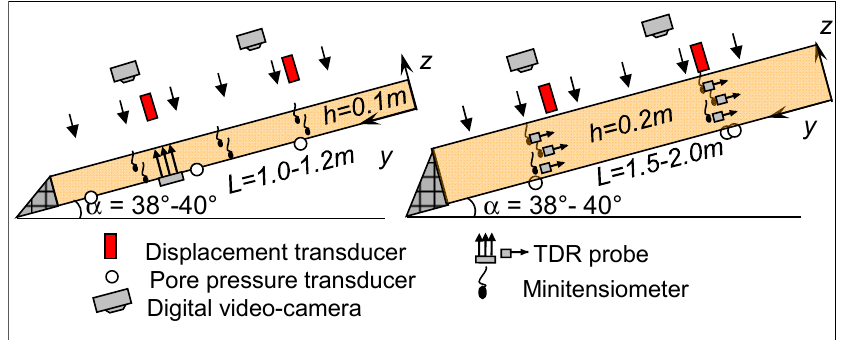
Figure 3. Sketch of the flume tests. Table 2. Flume infiltration tests.